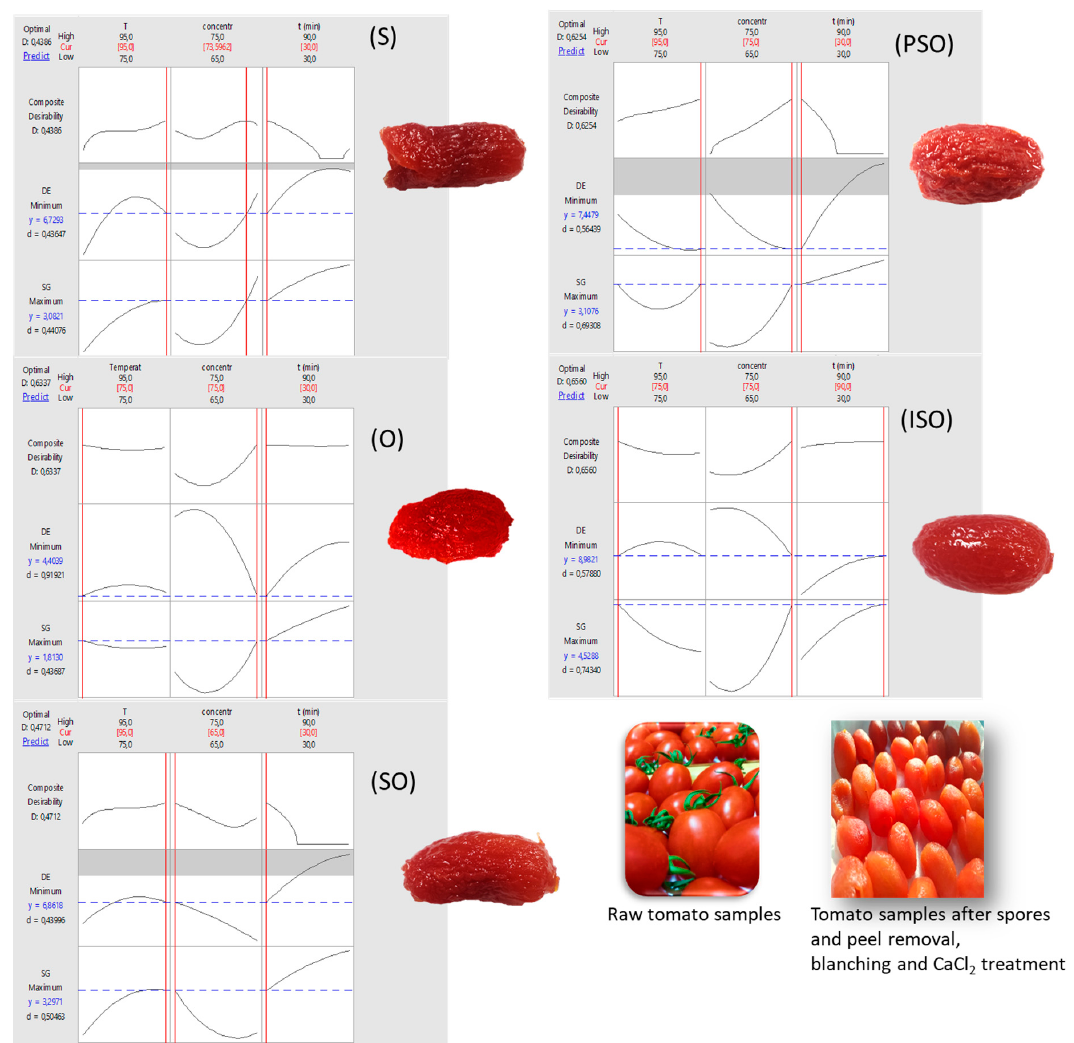
Figure 5. Desirability plots of variables for the different osmotic agents used (coded inside the parenthesis) and illustrations of tomato samples at the optimized conditions. Photos of the raw material, as well as for samples after the OD pretreatment (including spore and peel removal, blanching and CaCl 2 treatment) are also provided. Table 4. Optimum process conditions, estimated by desirability functions, for the different osmotic solutions (based on solid uptake and color retention criteria) and corresponding predicted values of mass transfer and quality parameters.